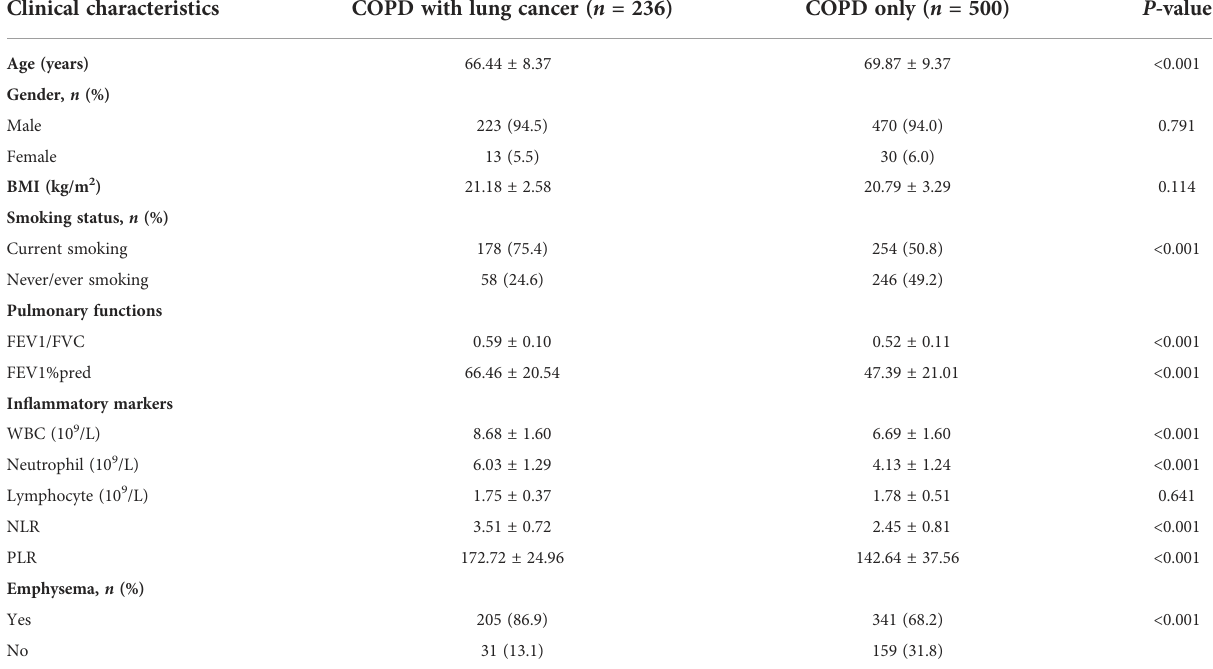
TABLE 1 Baseline characteristics of the study population. Clinical